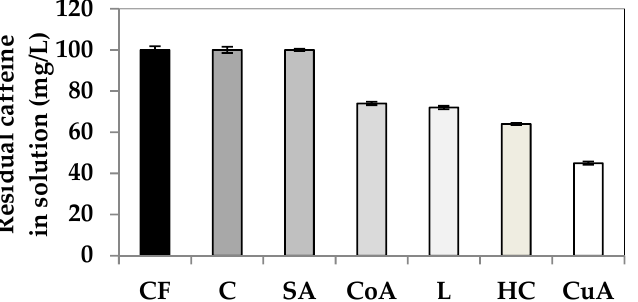
Figure 4. Residual levels of pure solution of caffeine (CF) (1 g/L) or in the aquatic mixtures of caffeine